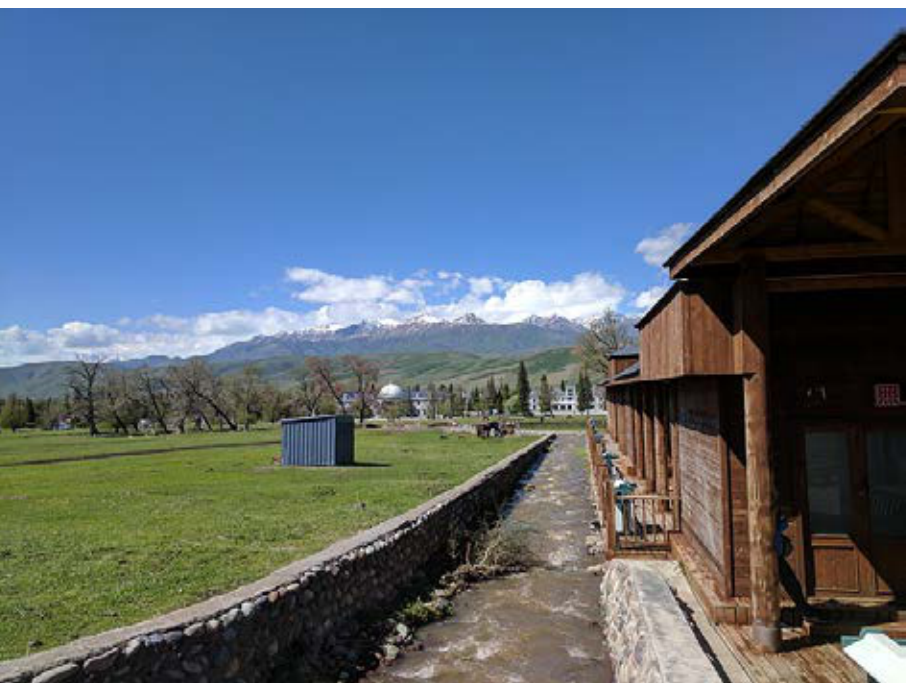
Figure 10. Grassland and town, Nalati,